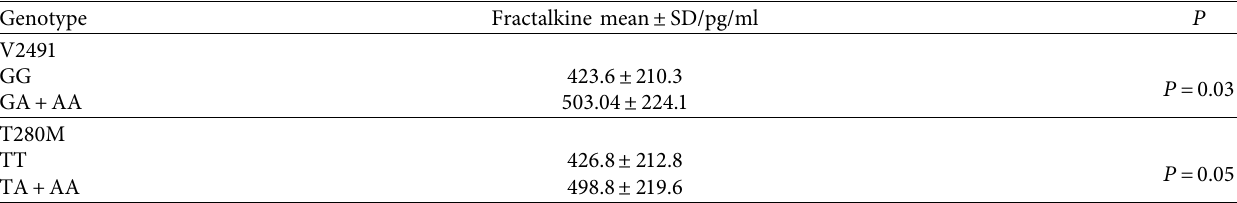
Table 3: Correlation between genotypes of V2491 and T280M and fractalkine